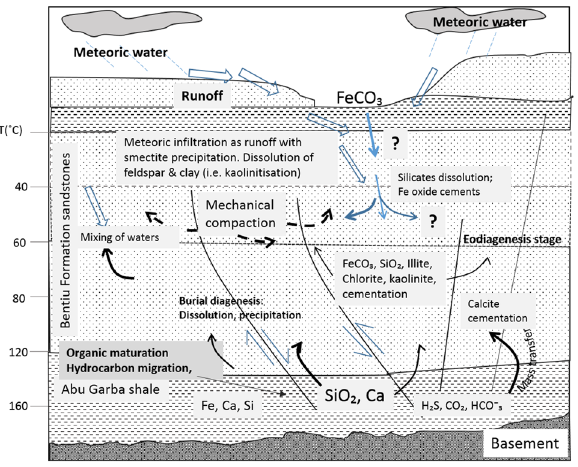
Figure 11. Diagenetic model for the Bentiu Formation. The Basin experienced eodiagenetic and shallow mesodiagenetic stages. Episodic meteoric water discharge causes little smetitic infiltration through porous paths, dissolution that gives rise to kaolinite. Also the organic-rich shale dissolution and hydrocarbon generation and migration at deeper depths mobilised silica, calcium and sulphide were precipitated to generate secondary porosity in the process. Note: temperature values are interpretive based on empirical studies 44,45